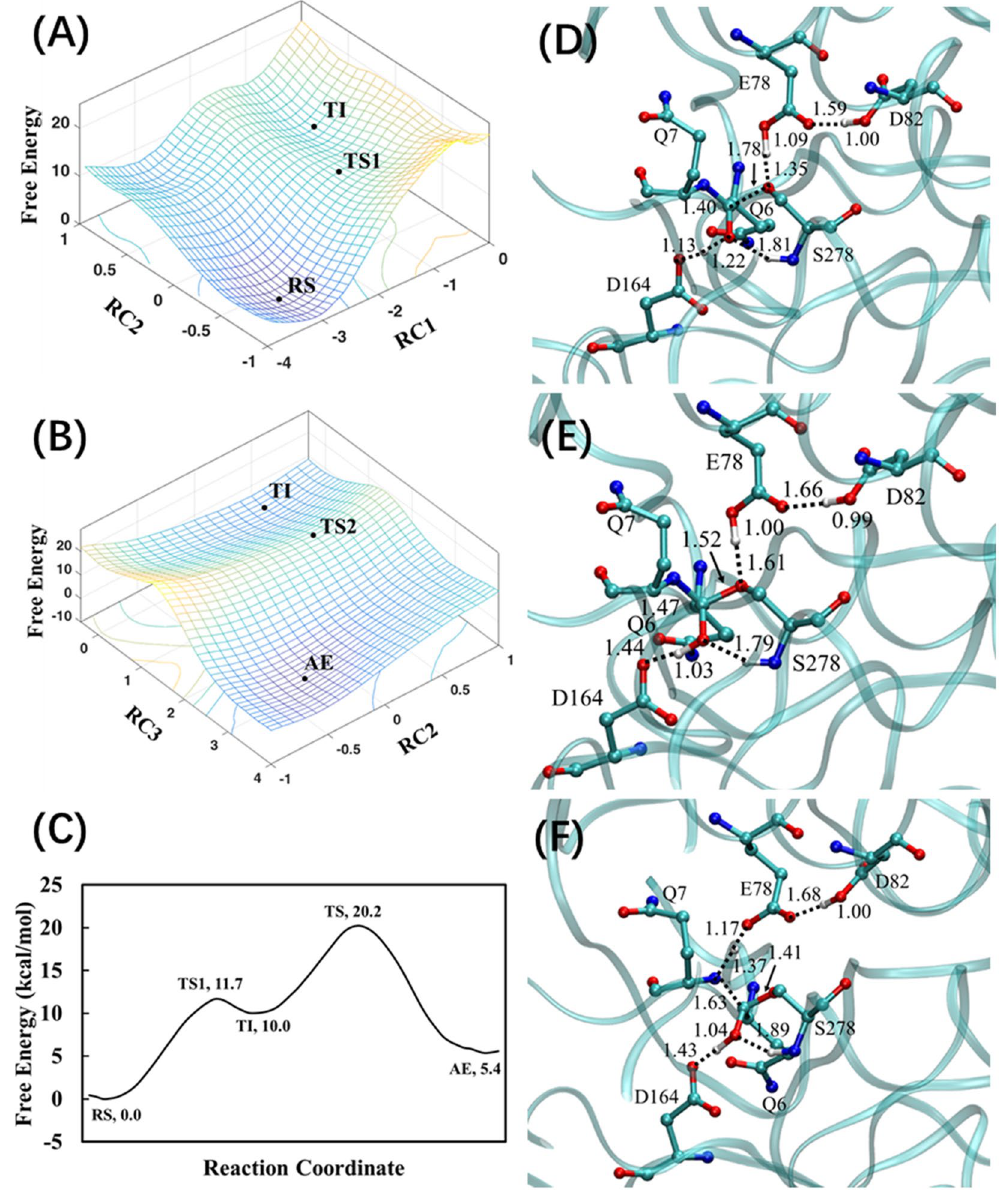
Figure 3. Free energy maps and average structures of KumaWT with the substrate peptide (PFPQPQQPF) for acylation process. ( A ) Use of RC1 and RC2 to simulate the formation of the TI in the acylation process; ( B ) RC2 and RC3 to simulate the decomposition of the TI. ( C ) Minimum free energy profile plotted on the basis of Fig. 3A,B. Average structures of TS1 ( D ), TI ( E ), and AE ( F ). The distances are all in Å. The energies are in kcal/mol. All transition states are approximate